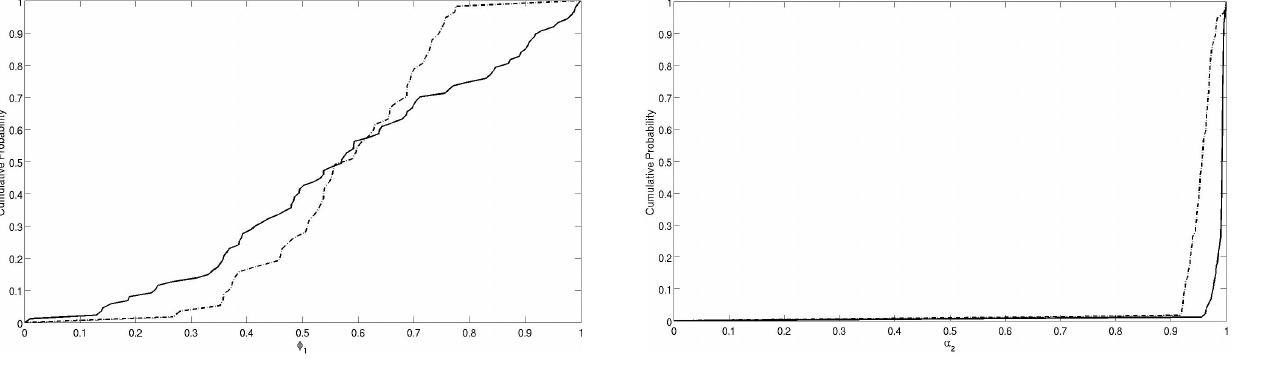
Fig. 5. Cumulative distribution of φ 1 for behavioural parameter sets of the two situations considered: Analysis using the full data set with (κ min , κ max ) =( − 10, 0.98) (solid) and with the disinformative data removed with (κ min , κ max ) =( − 5, 0.93) (dot-dash).